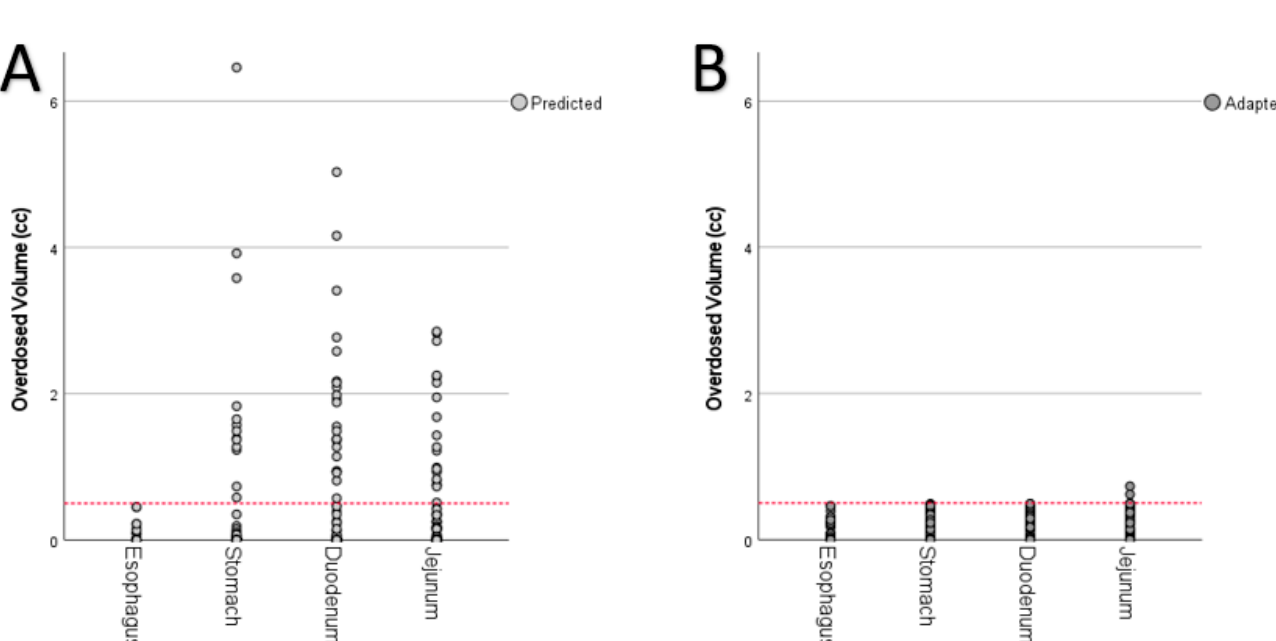
Figure 4. Planning target volume coverage in the predicted plans ( A ) vs. adapted plans ( B ) each in direct comparison with the baseline plan. One verticle column represents one tratment plan. The dashed red line represents the aimed coverage of 95%.